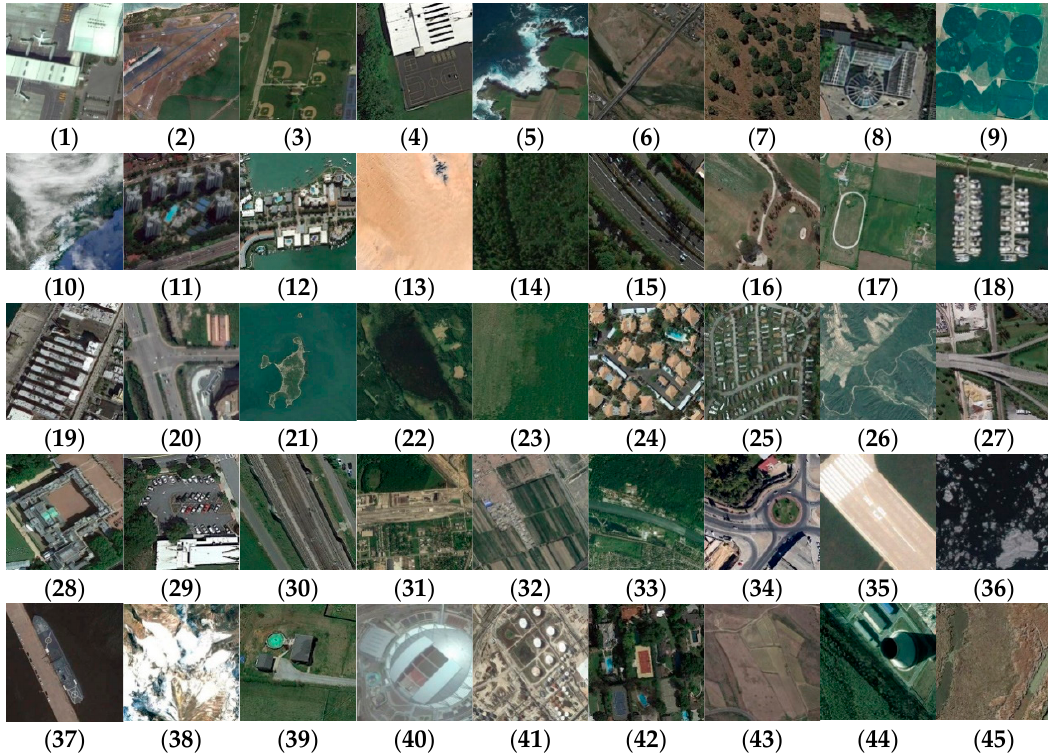
Figure 3. Class representatives of NWPU-RESISC45 dataset: ( 1 ) airplane; ( 2 ) airport; ( 3 ) baseball diamond; ( 4 ) basketball court; ( 5 ) beach; ( 6 ) bridge; ( 7 ) chaparral; ( 8 ) church; ( 9 ) circular farmland; ( 10 )